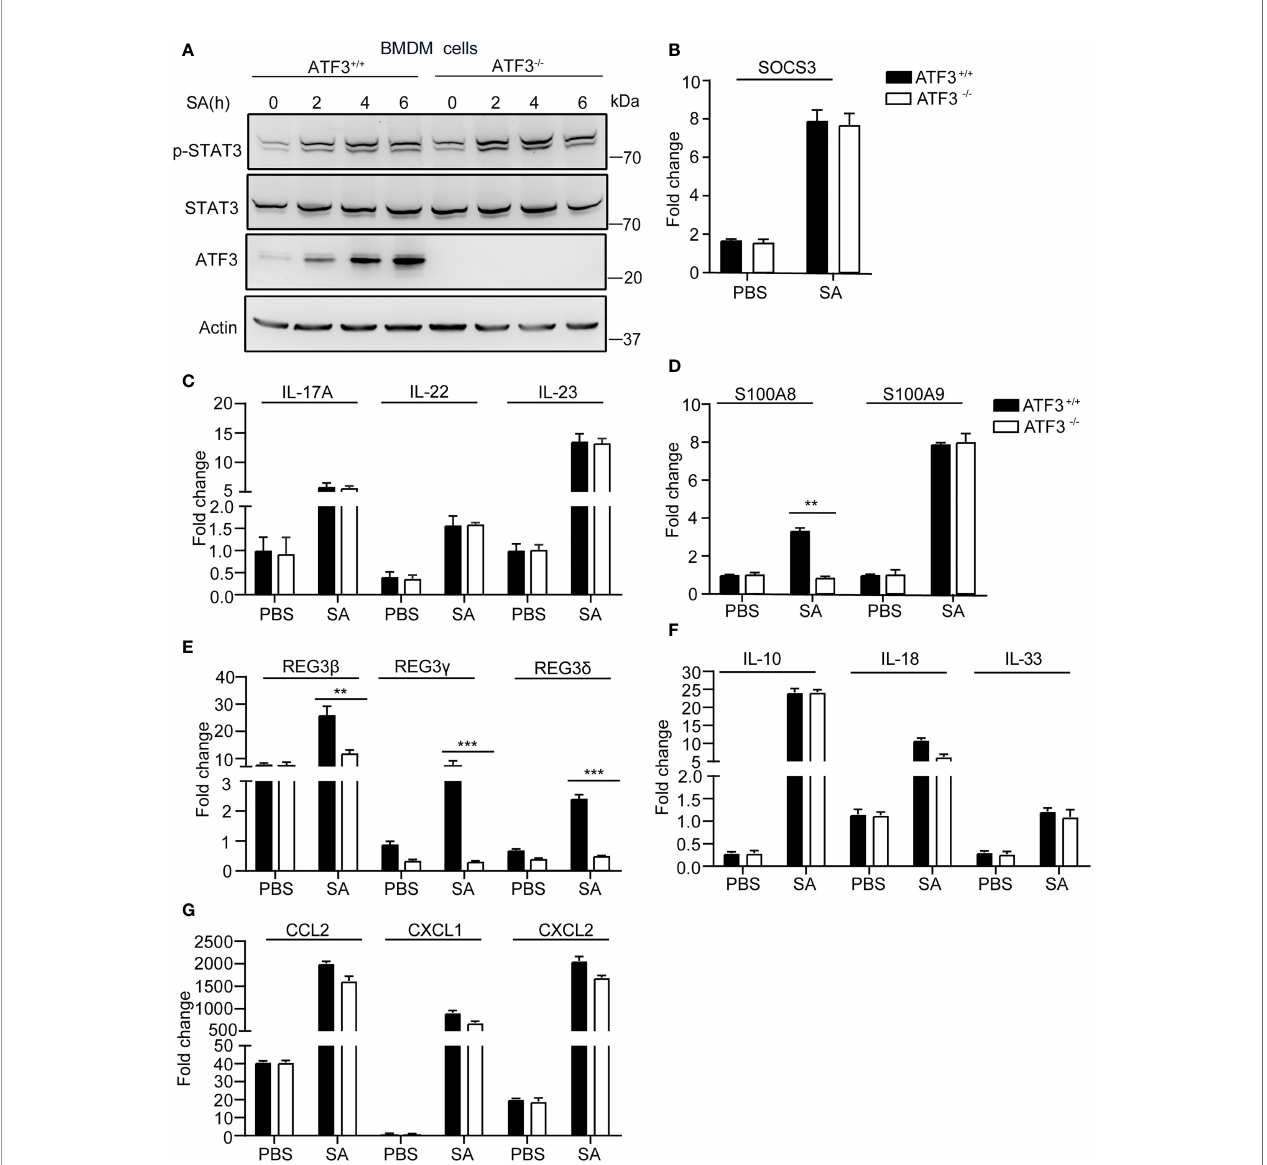
FIGURE 5 | ATF3 enhances macrophage bacterial clearance dependent on an antimicrobial signature. WT and ATF3 KO BMDM cells or mice were infected with S. aureus (MOI = 1) for the indicated time periods. (A, B) The cells were lysed; the protein levels of STAT3 and p-STAT3 were analyzed, and the amount of SOCS3 mRNA was detected using quantitative PCR (qPCR). (C – G) qPCR analysis of the indicated cytokines (IL-17, IL-22, and IL-23), AMPs (S100A8,S100A9,REG3 b , REG3 g , REG3 d ), and other cytokines (IL-10, IL-18, and IL-33), chemokines (CCL2, CXCL1, and CXCL2) associated with bactericidal activity. All results are from three independent experiments and are expressed as mean ± SD. * P < 0.05, ** P < 0.01, *** P < 0.001 by the Student ’ s t